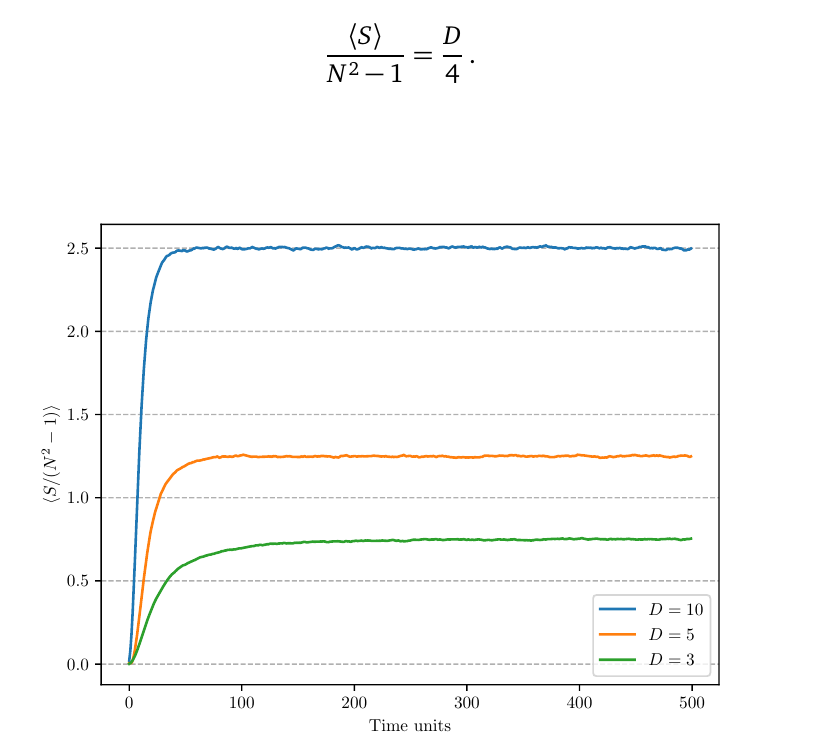
Figure 15: The average action (normalized) for the YM type model with various D .